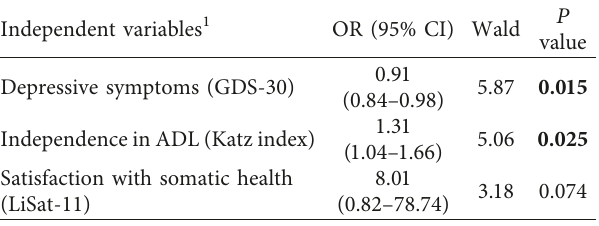
Table 4: Multivariable logistic regression model of associations with patient satisfaction with care (not satisfied � 0; satisfied � 1), n � 90.